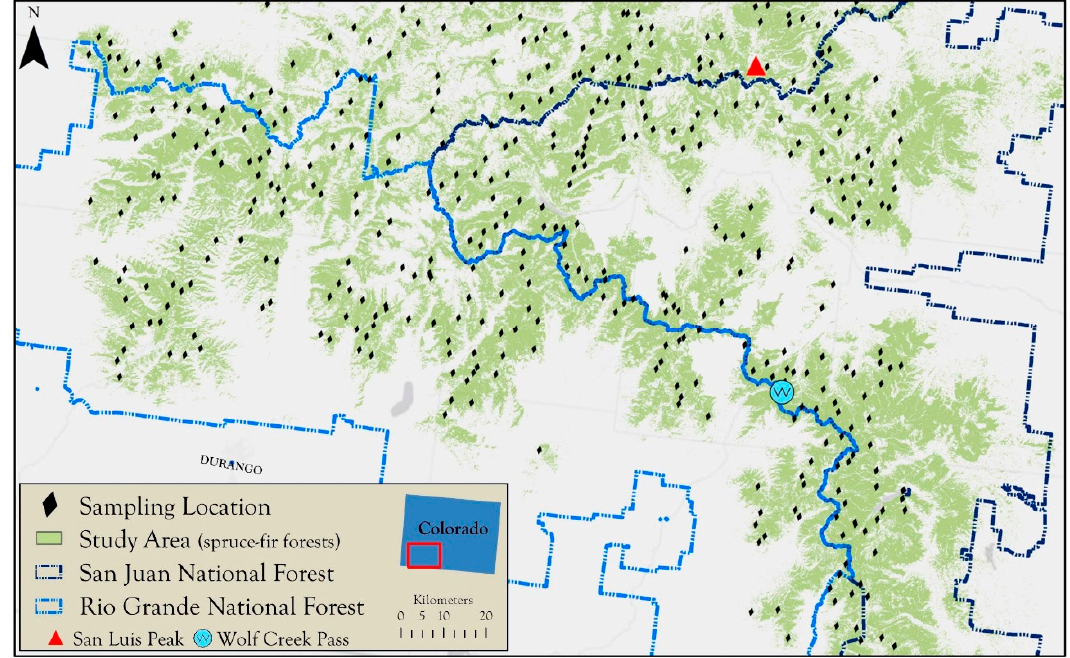
Figure 1. The study area located in and around San Juan and Rio Grande National Forests.